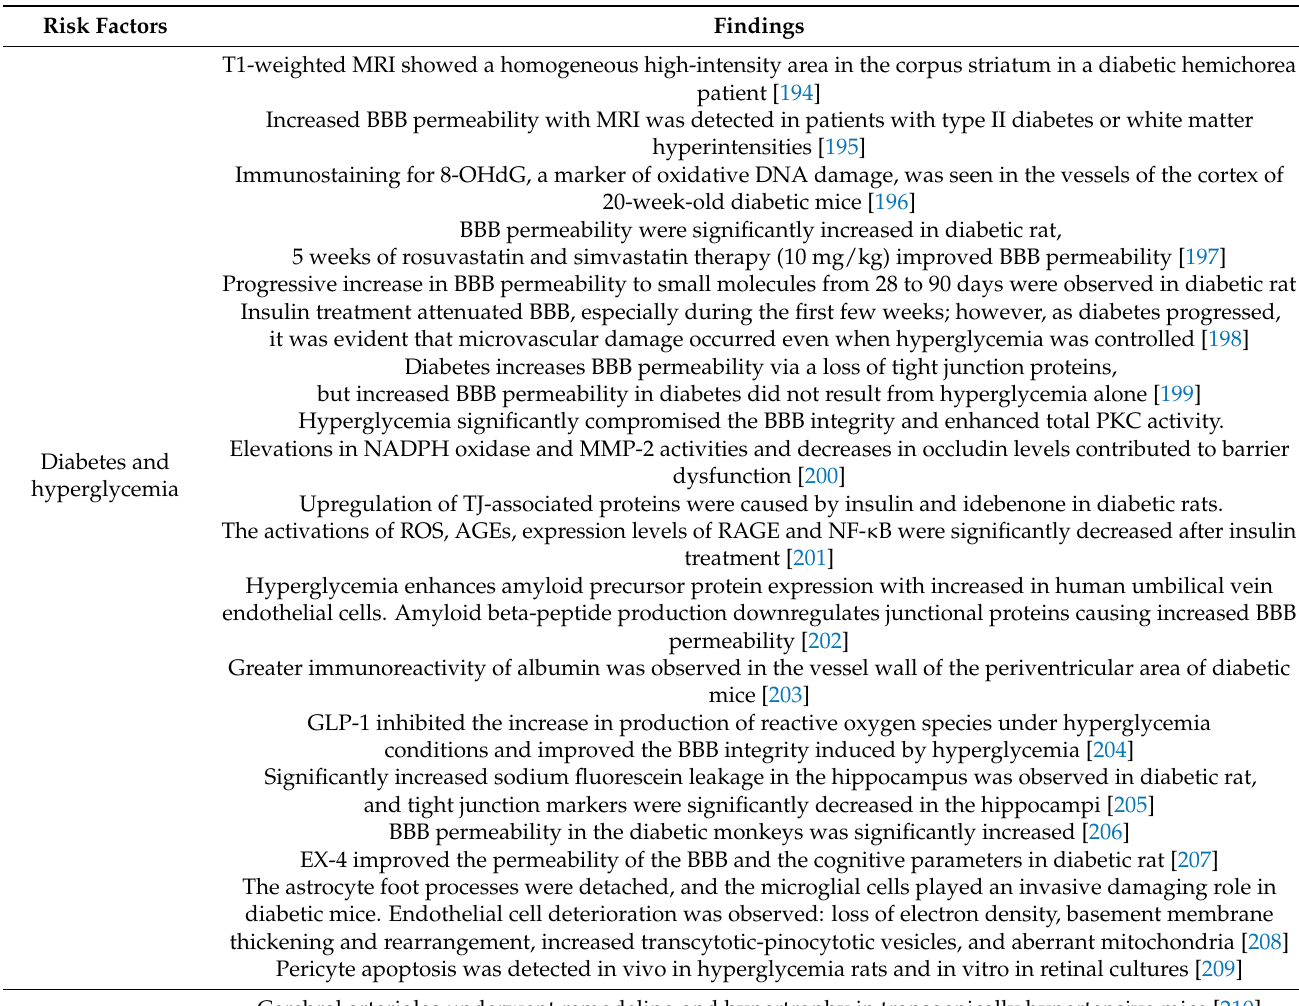
Table 2. Predisposition of NVU to vascular risk